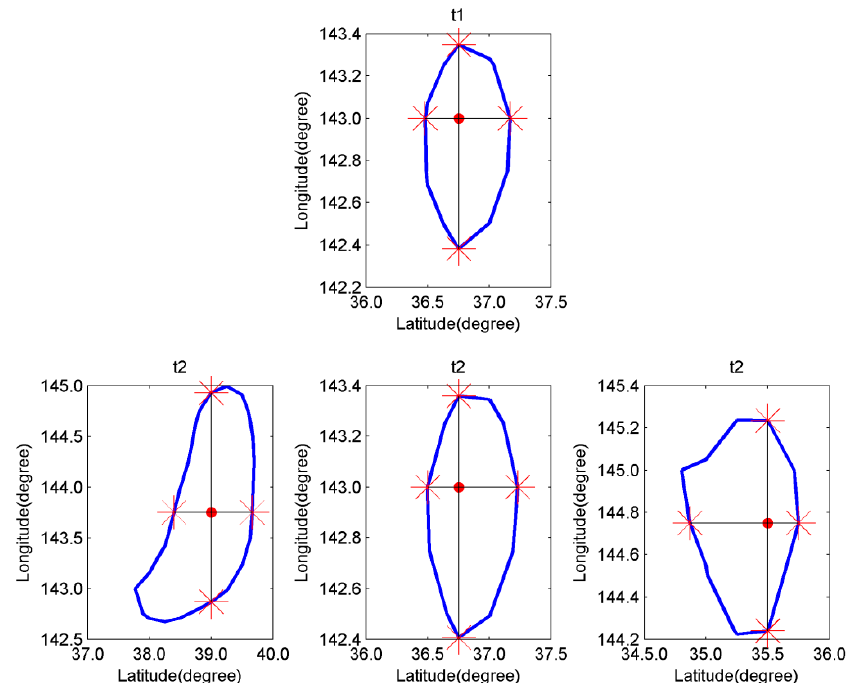
Figure 4. Example eddy at the t 1 time step and its candidate eddies at the t 2 time step.